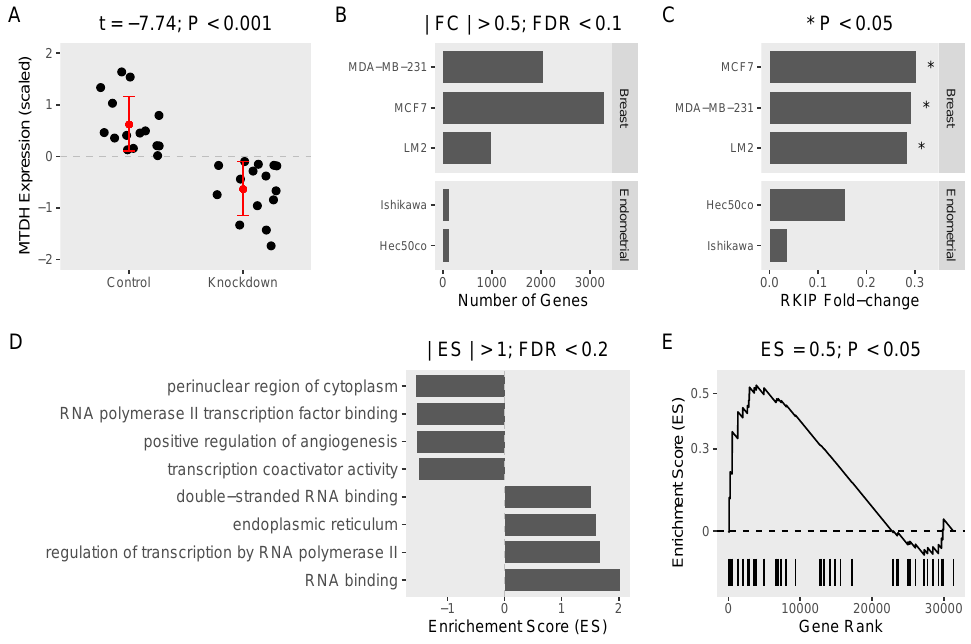
Figure 2. Gene expression and gene set enrichment analysis of MTDH -knockdown in cancer cell lines. Datasets obtained from three MTDH -knockdown breast cells (MCF-7, MDA-MB-231, and LM2) and two MTDH -knockdown endometrial (Ishikawa, and Hec50co) cancer cell lines were compared to control cells (three samples of each cell line). ( A ) Expression of MTDH (scaled fold-change ( log 2 )) in five knockdown breast and endometrial cancer cell lines and corresponding five control cells. The mean difference in expression was tested using t -test. ( B ) Gene expression was compared between knockdown and control cells in each cell line. Fold-change (FC) was calculated and tested for significance using false-discovery rate (FDR). ( C ) Fold-changes of RKIP in each cell line are shown. ( D ) Genes were ranked based on fold-change from the most positively changed to the most negatively changed in knockdown vs. control cells. Enrichment of MTDH-related gene ontology terms was calculated as the over-representation of the term members in the top or the bottom of the ranked list of differentially expressed genes in one or more breast cancer cell lines. Enrichment scores (ES) > 1 and FDR < 0.2 are shown. ( E ) Enrichment of the “negative regulation of autophagy”